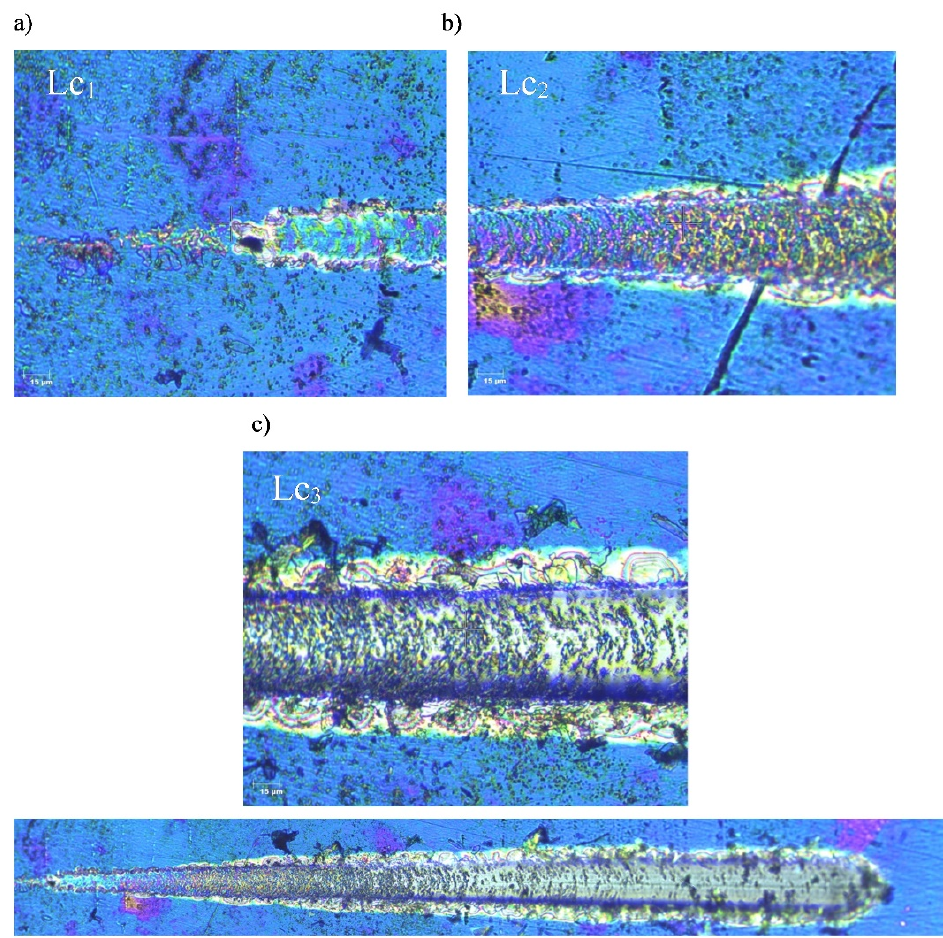
Figure 9. Examples of the types of damage registered during the scratch test for the ALD ZnO thin film deposited after 1500 cycles: ( a ) crack Lc 1 ; ( b ) delamination Lc 2 ; ( c ) complete break Lc 3.